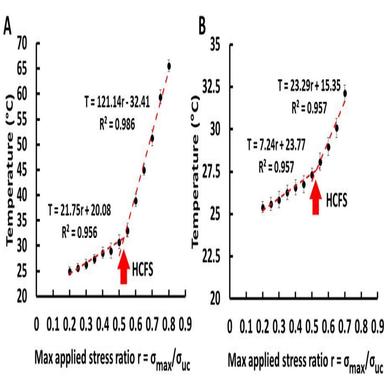
Conventional fatigue testing results for compressive σ-Nf graphs. (A) Type A configuration where σuc = 261.7 MPa, (B) Type B configuration where σuc = 231.9 MPa. Applied stress ratio was R = σmin/σmax = 0.1. Cycling frequency was 5 Hz. HCFS ranges are between dashed lines for 1 and 5 million cycles.